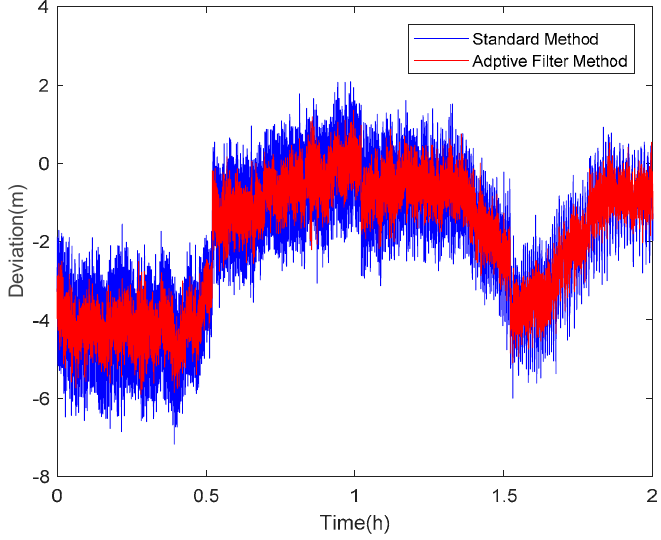
Figure 22. Pseudorange residuals comparison before and after frequency spectrum smoothing (R20, 2 h).